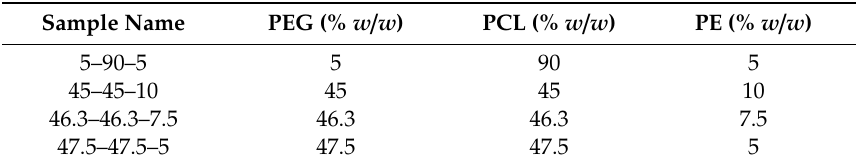
Table 1. Compositions of the studied polyurethanes